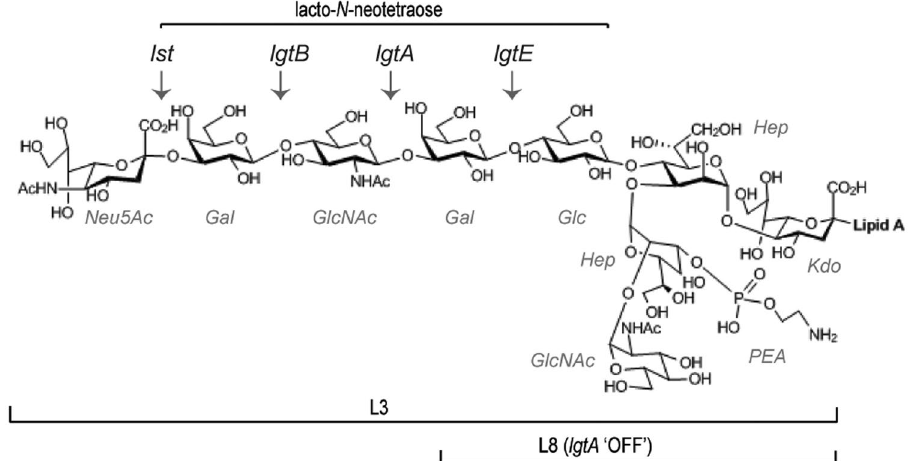
Figure 2. Chemical structure of LOS from N. meningitidis MC58. Phase variable glycosyltransferase genes involved in LOS biosynthesis are shown ( lst, lgtB , lgtA, lgtE ), and arrows indicate the sugars added by these enzymes. The structures of the L3 and L8 immunotypes are indicated. L8 immunotype is expressed when lgtA is phase varied off. The terminal lacto- N -neotetraose epitope of L3 LOS is